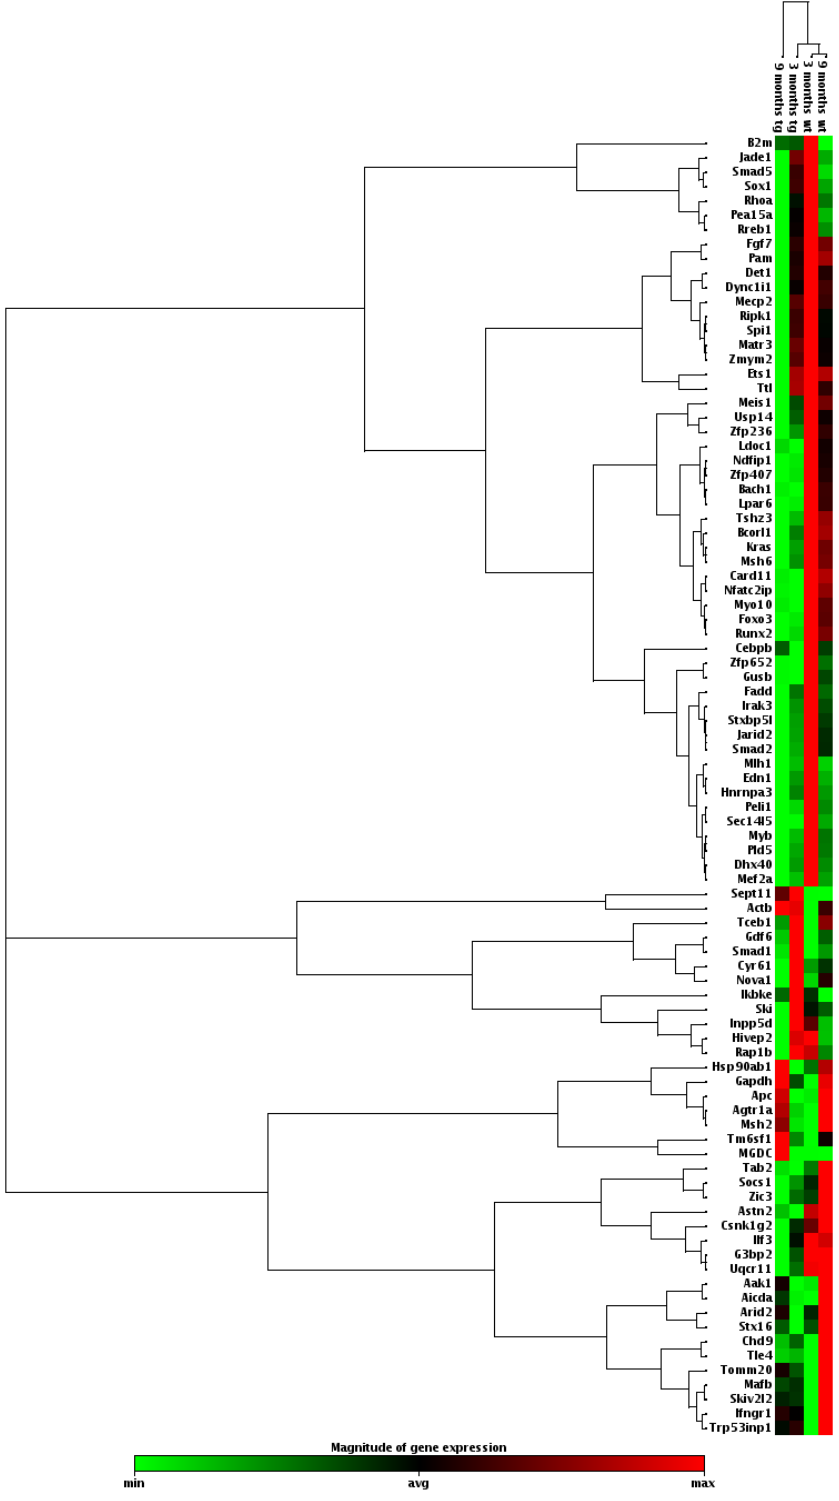
Figure 8. Heat map of miR-155 targets by PCR array profiling for pooled samples from 3xTg-AD mice (tg) and age-matched wild-type (WT) mice. RNA was isolated from cortical brain samples of WT and 3xTg-AD animals at 3- and 9-month-old and analyzed for miR-155 target genes by RT-qPCR. Results are expressed as magnitude of gene expression from a pool of n = 4 animals per experimental group.